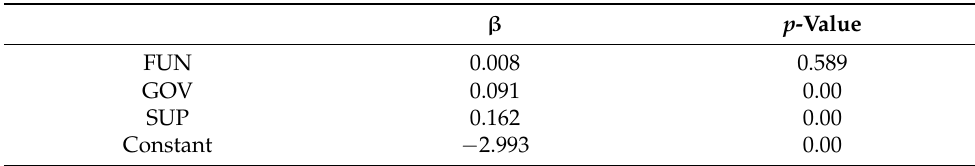
Table 11. Logistic regression results for COM3 (co-operation with other actors of the ecosystem) independent variable.